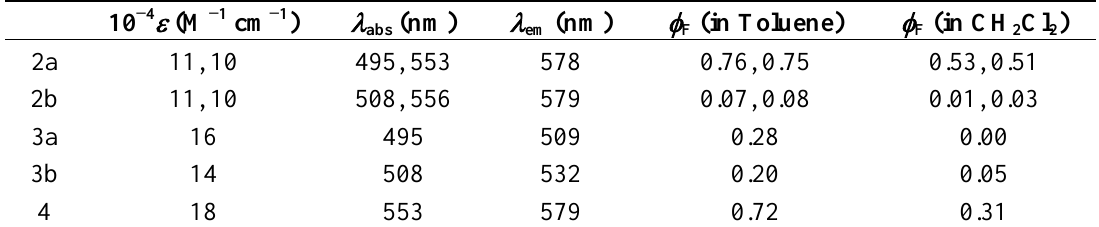
Table 1. Photochemical properties of 2a , 2b , 3a , 3b , and 4